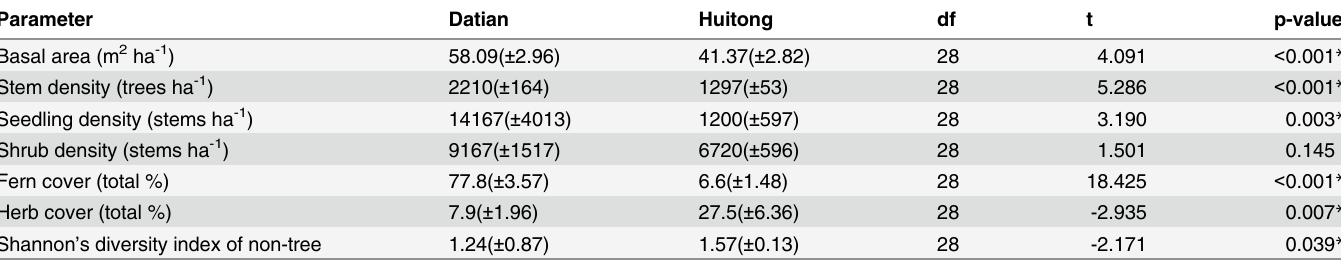
Table 4. Summary of the stand structure traits between sites (mean ± SE).